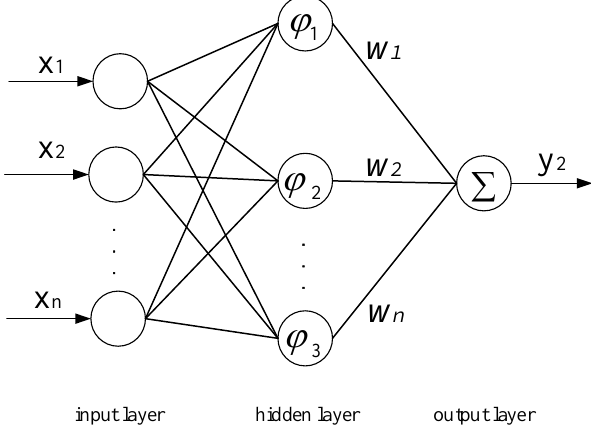
Figure 6. Radical basic function neural network model structure.